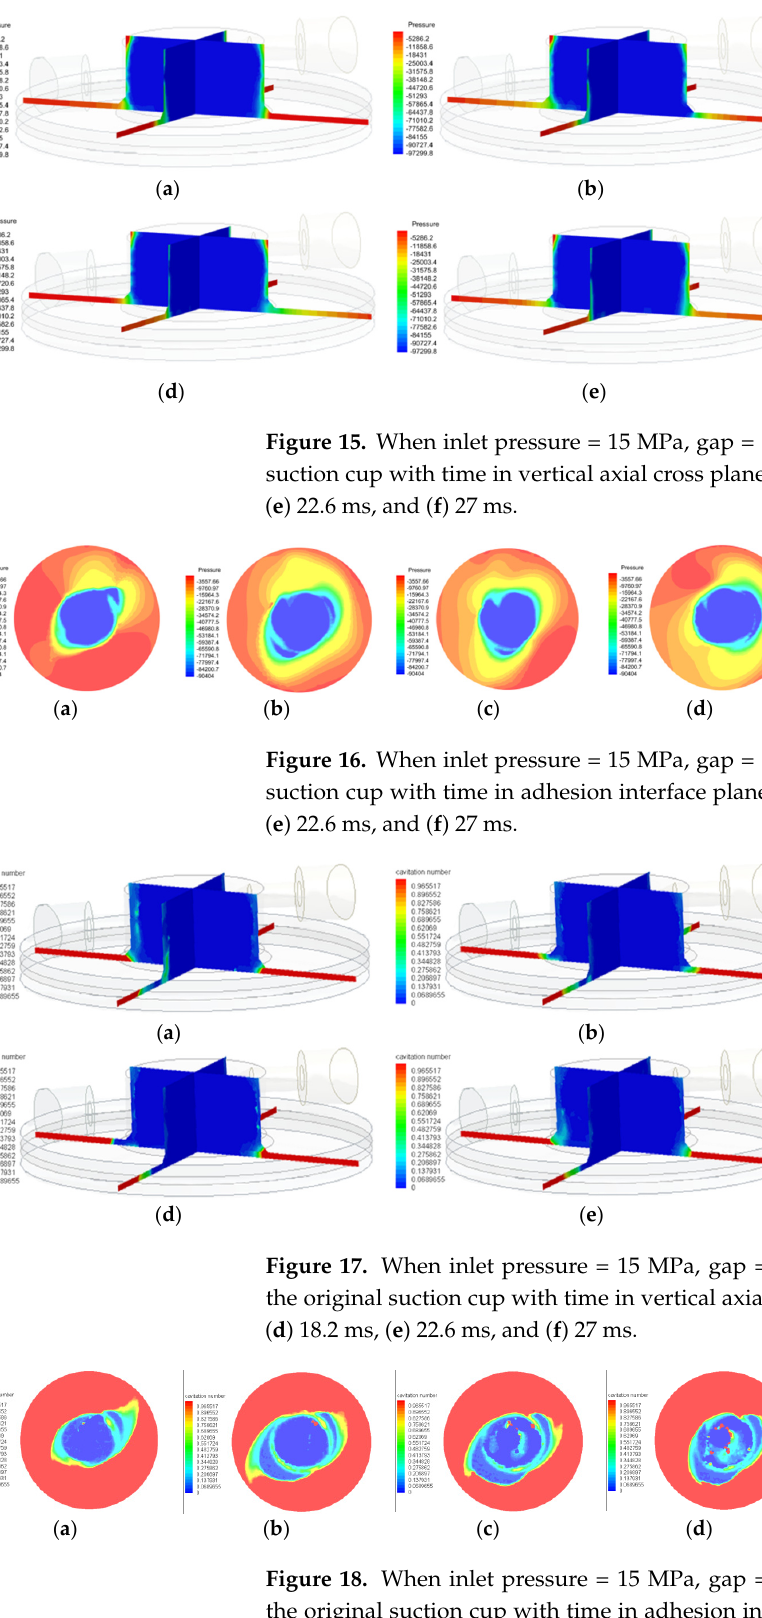
ms, ( e ) 22.6 ms, and ( f ) 27 ms.